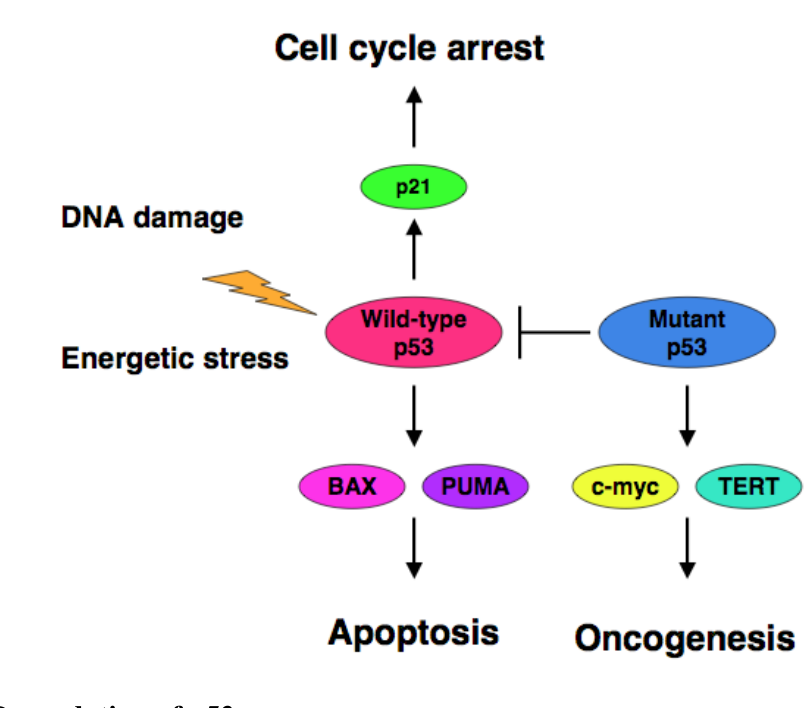
Figure 1. Dominant-negative effect of mutant p53 on wild-type p53. Pro-apoptotic function of p53 is significantly inhibited by certain p53 mutants which induce malignant transformation through up-regulation of c-myc and